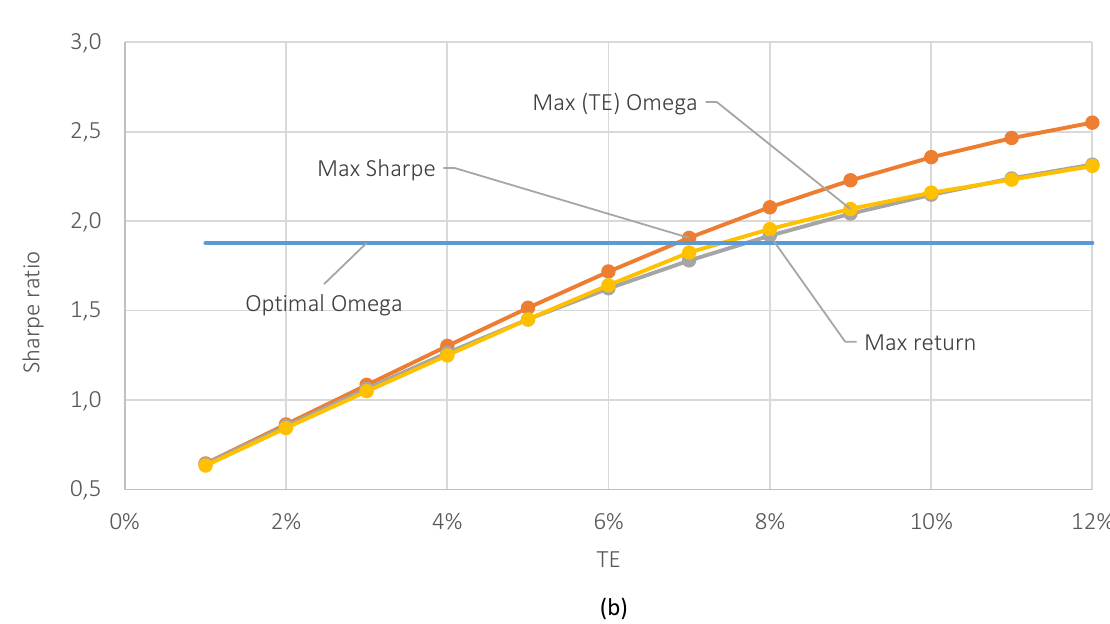
Figure 7(a). Return/risk profiles for relevant portfolios as a function of